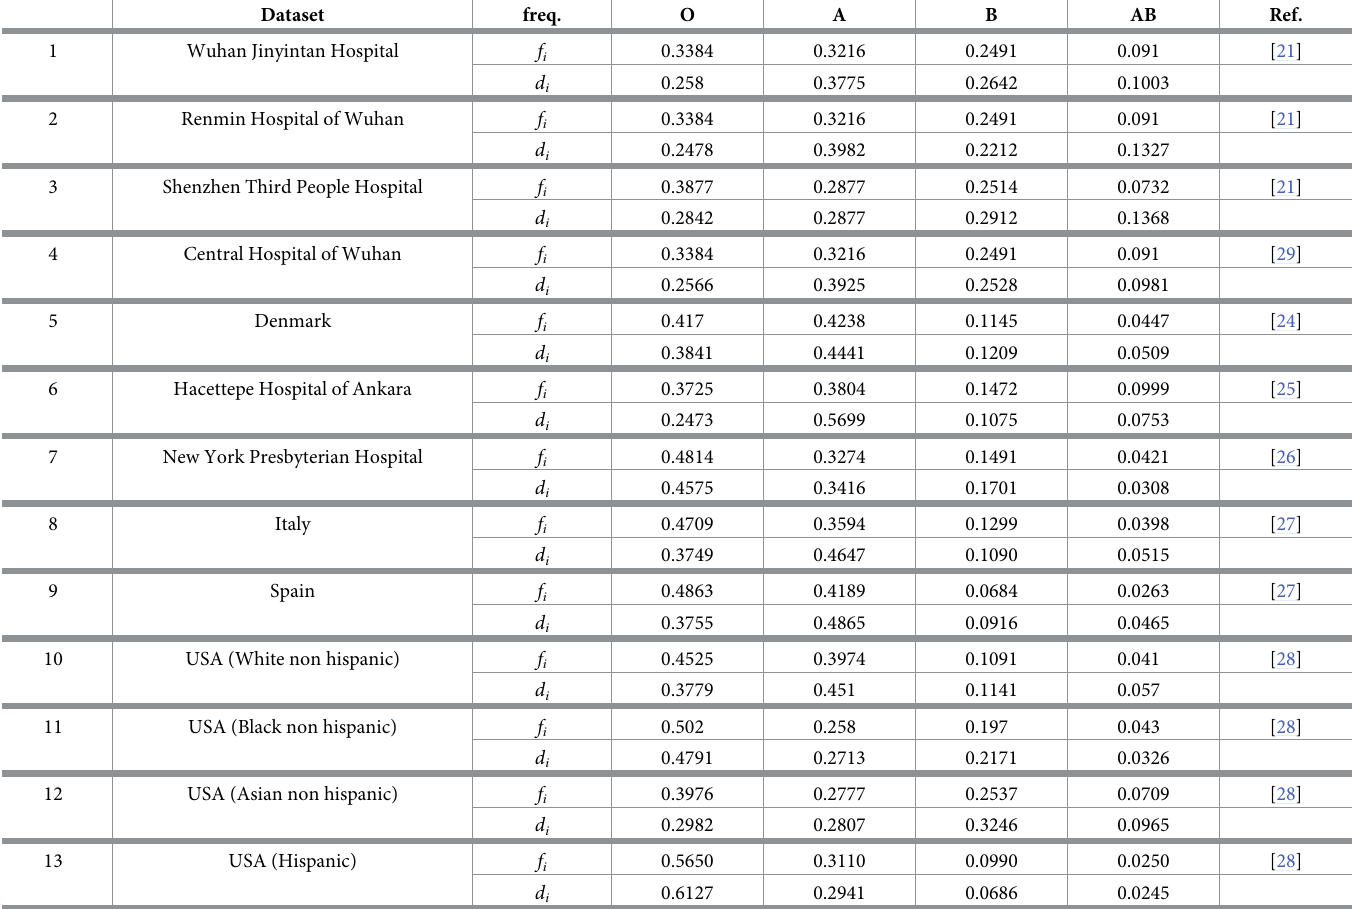
Table 1. Data used to determine the quantities plotted in Figs 2 and 3: ln( d of population with blood group i and p ð 4 Þ